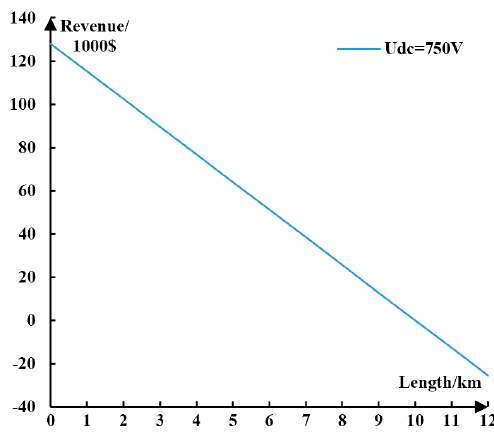
Figure 11. Total revenue with different DC line length.